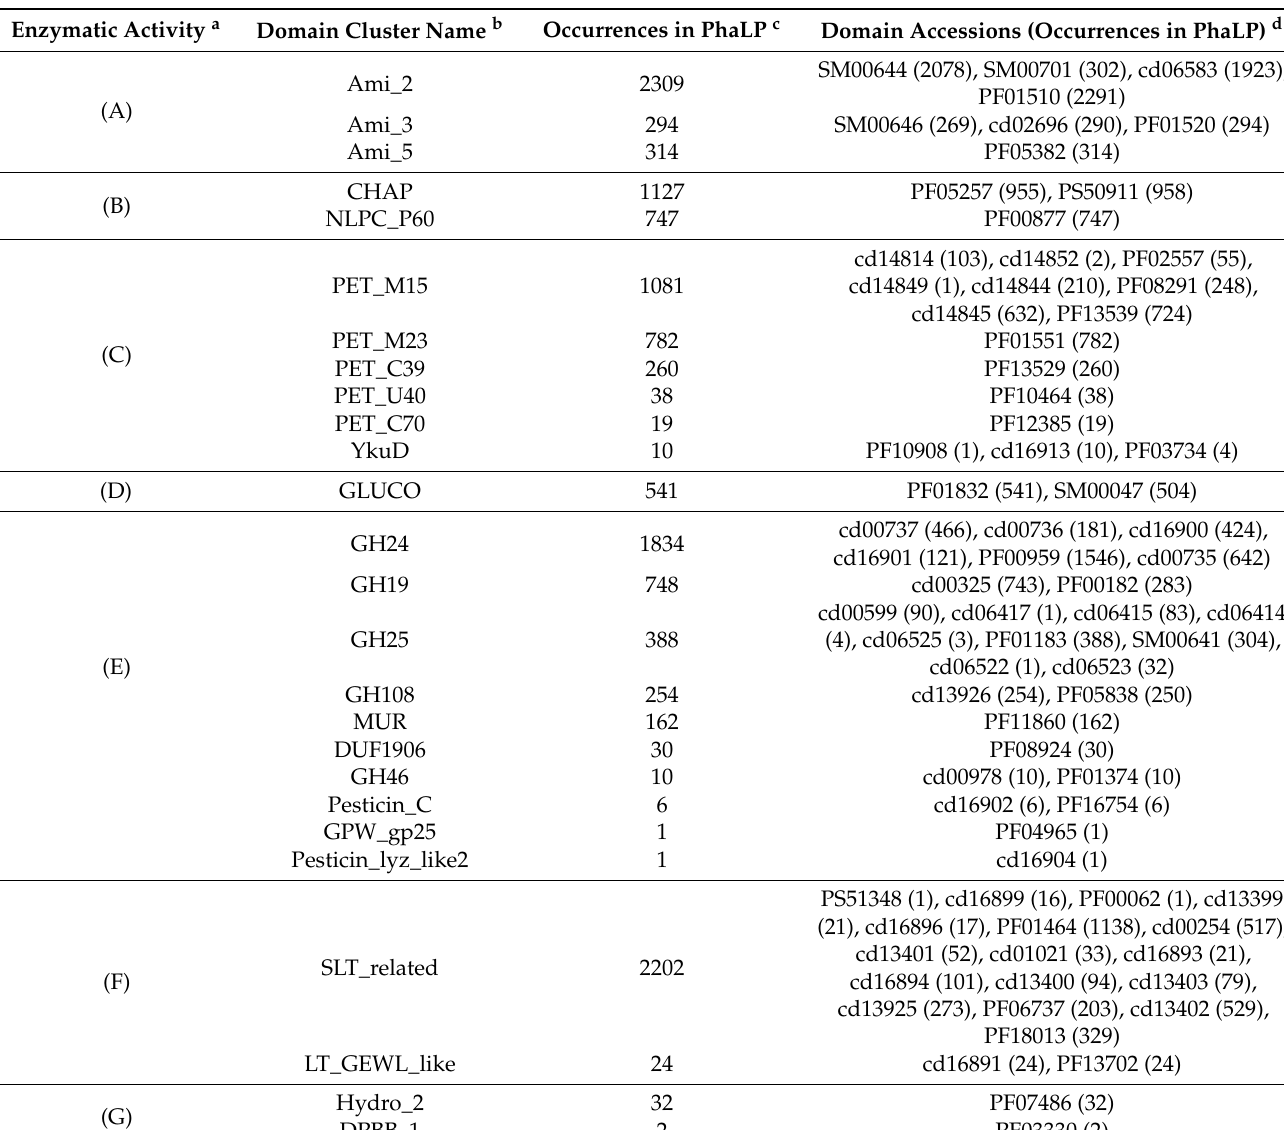
Table 1. EAD clusters observed in phage lytic proteins and their related domain accessions from various protein databases, grouped per enzymatic